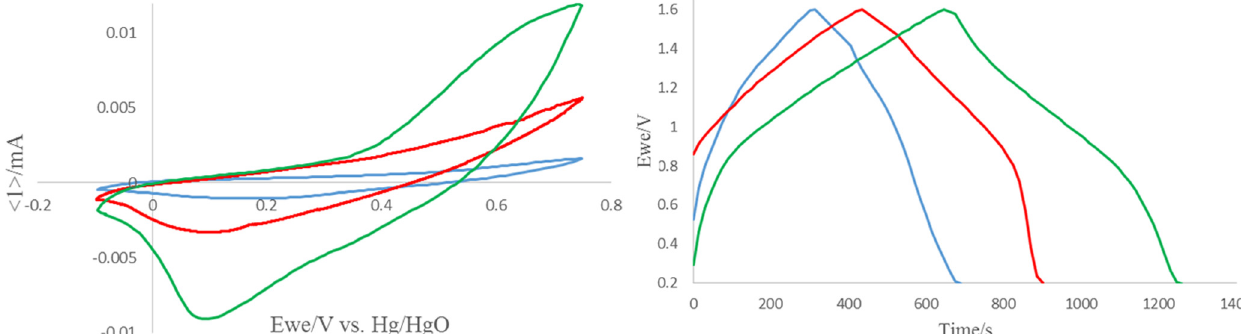
Fig. 3. CV curves (left) and CD behaviour (right) for NiCo 2 O 4 blank (blue), ESM templated (red), PMMA